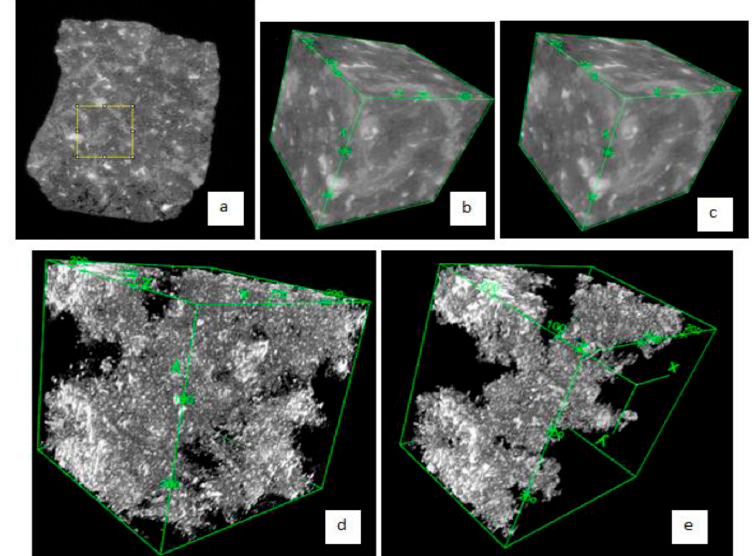
Figure 2. Extraction and visualization of pore space from CT images of deteriorated cement pastes: ( a ) An 8-bit representative slice (2000 × 2000 voxels) obtained from OPC-de2; ( b ) The volume of interest (300 3 voxels) obtained from the normalized data set; ( c ) The resulting 3D stack after denoising; ( d ) A 3D visualization of the segmented total porosity of the VOI; ( e ) A 3D visualization of the largest percolating pore cluster in the VOI or the effective porosity of the VOI.